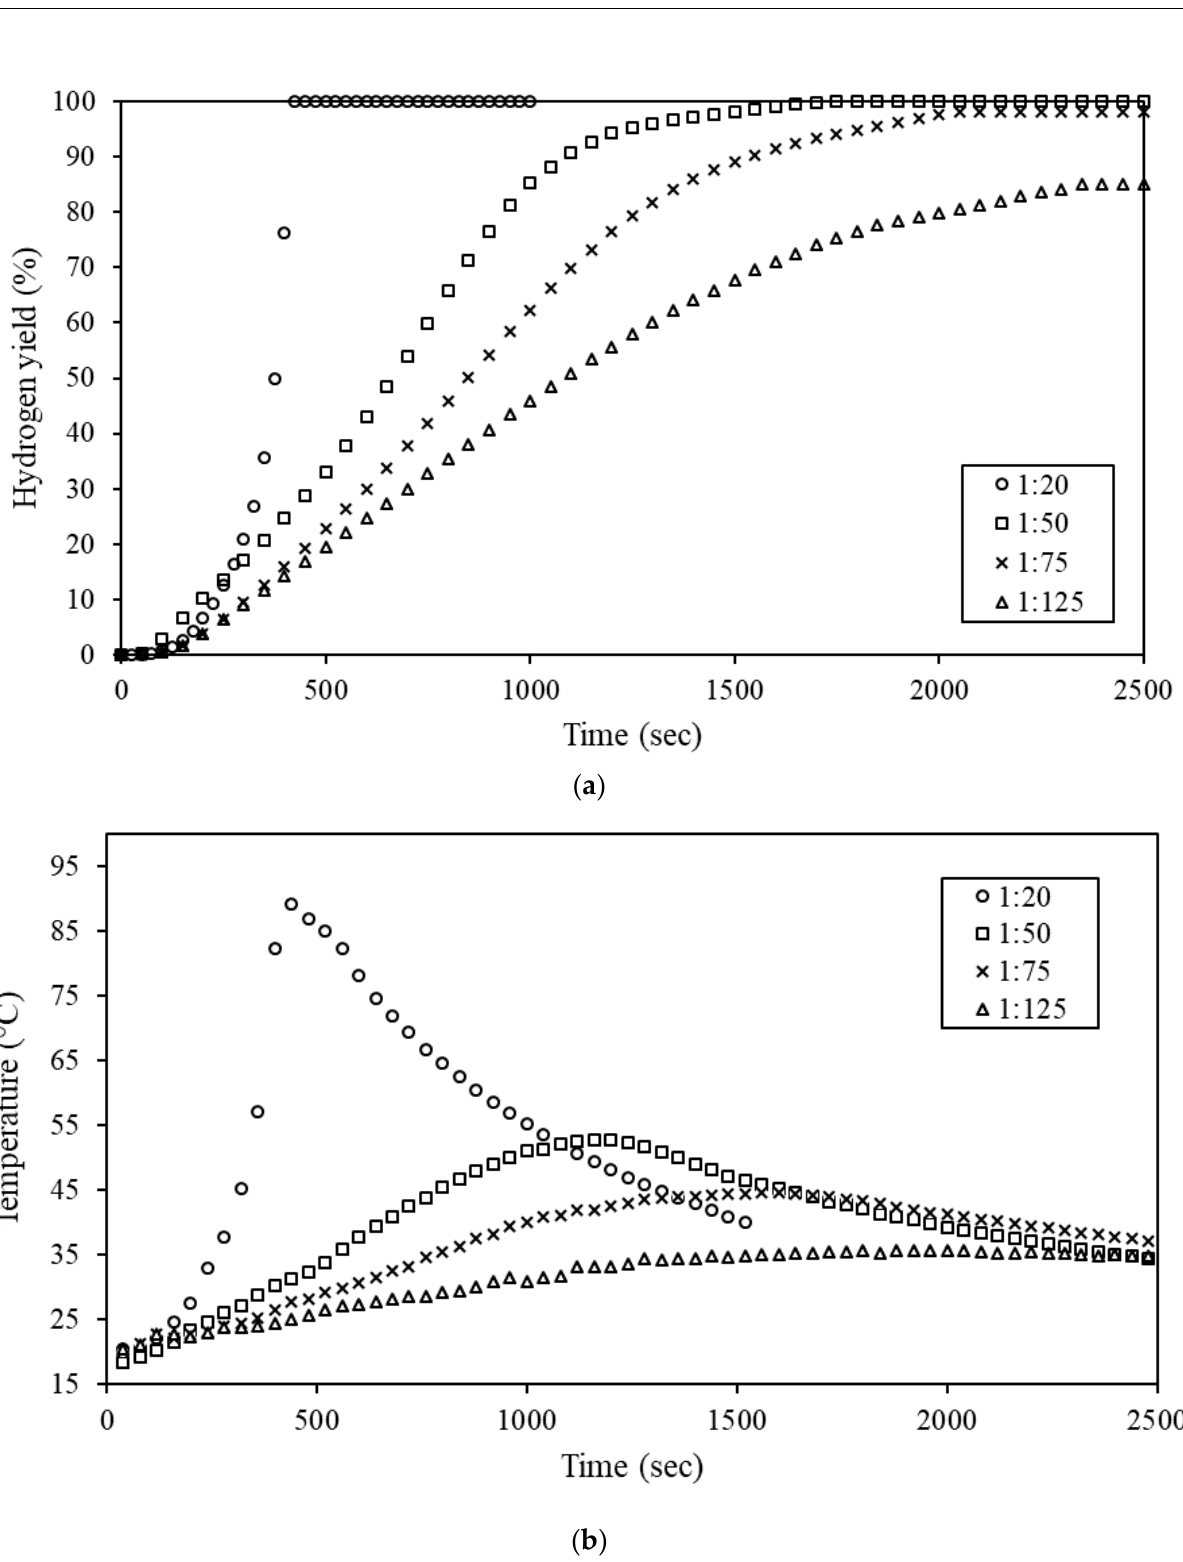
Figure 5. Effect of mass ratio (1:20 to 1:125) on the hydrogen yield of Al-9.25% Bi-0.75% Ni ( a ) and the change in reaction temperature during hydrolysis ( b ).